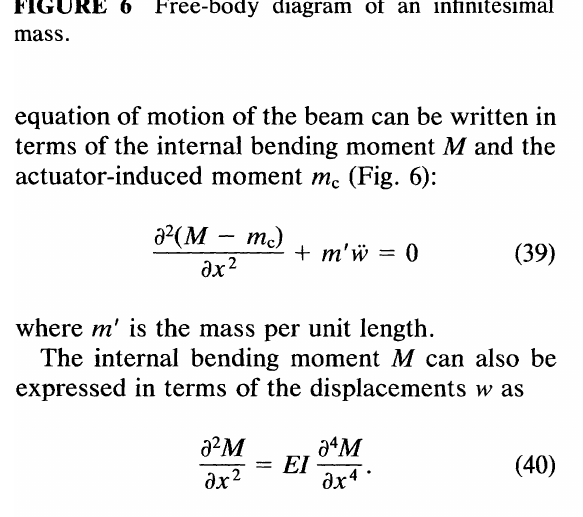
FIGURE 6 Free-body diagram of an infinitesimal mass.